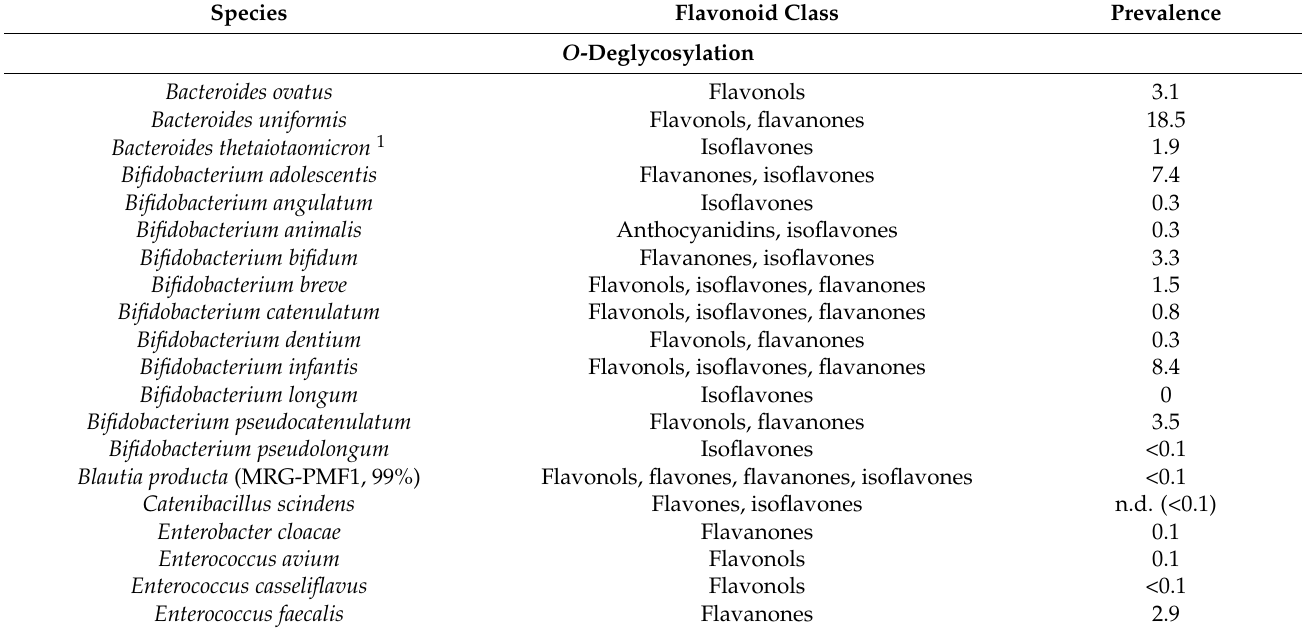
Table 2. Flavonoid-modifying gut bacterial species and their prevalence (percent of MAGs from all samples involved) as MAGs derived from the taxonomic classification in the metadata of the UHGG